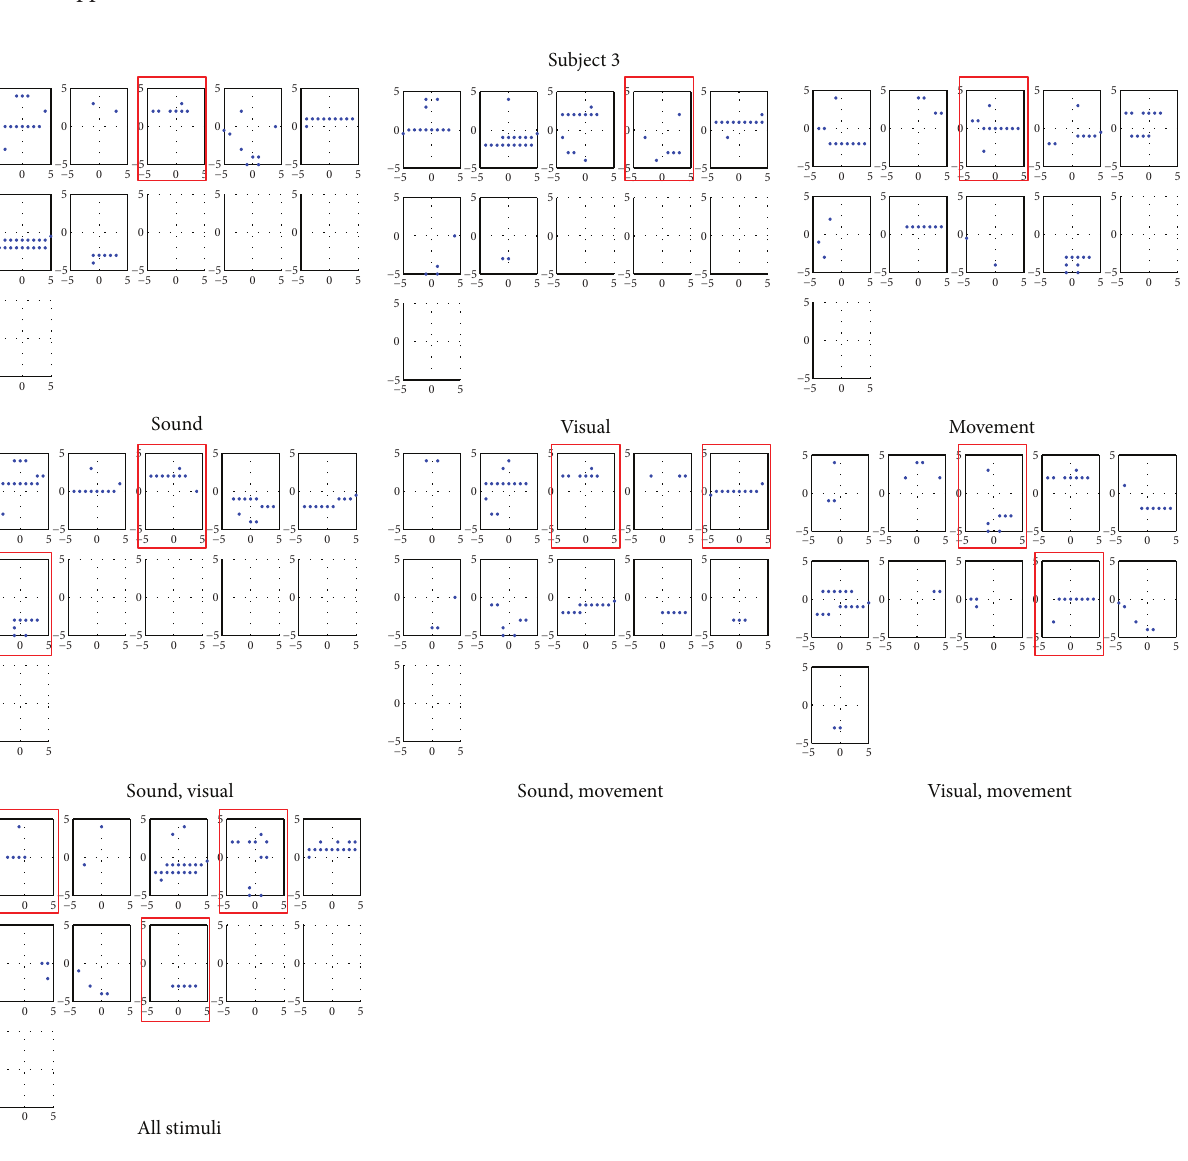
Figure 5: Results of grouping for Subject 3.